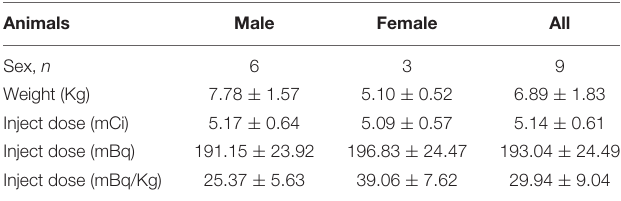
TABLE 1 | Summary of the characteristics of the animals before PET imaging with [ 18 F]-4-ADAM. Animals Male Female